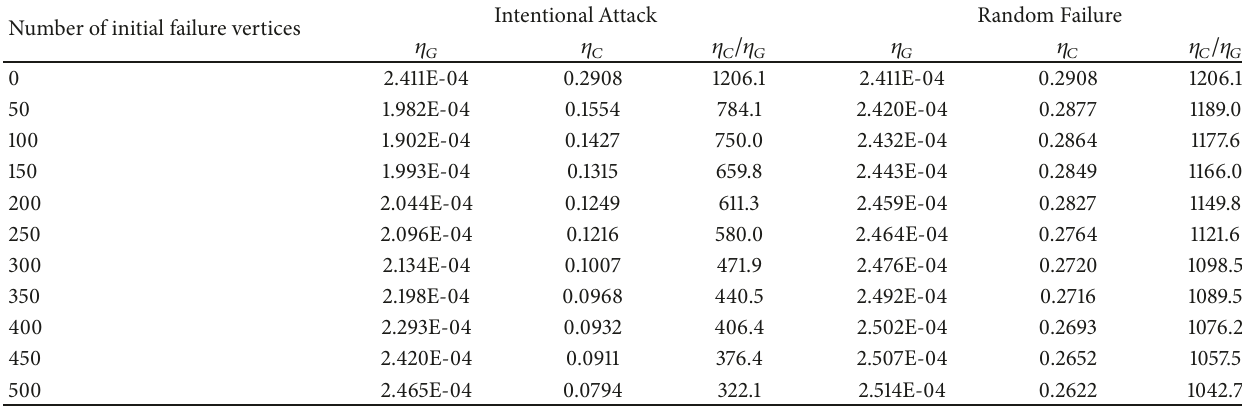
Table 5: Efficiency of the shareholding networks under attacks or